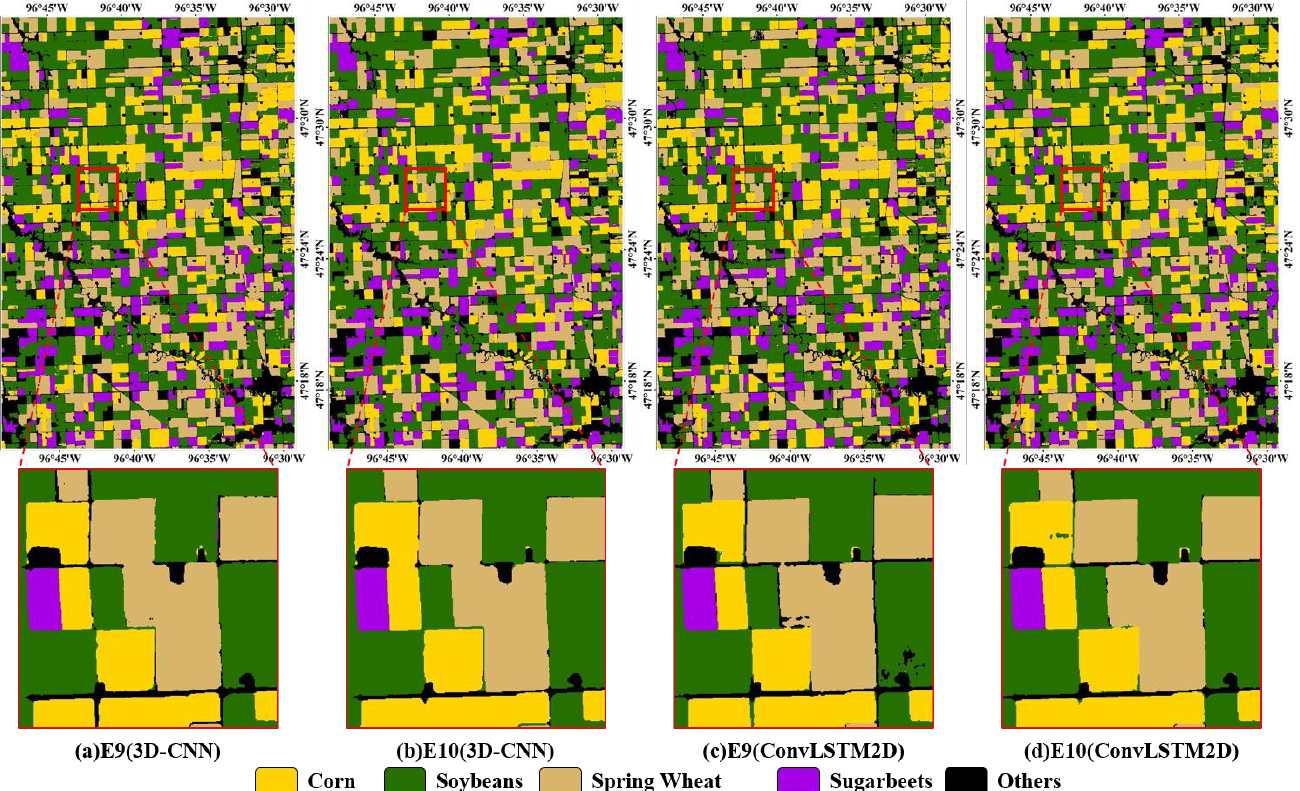
Figure 7. Crop classification results based on temporal, spectral, and spatial information.